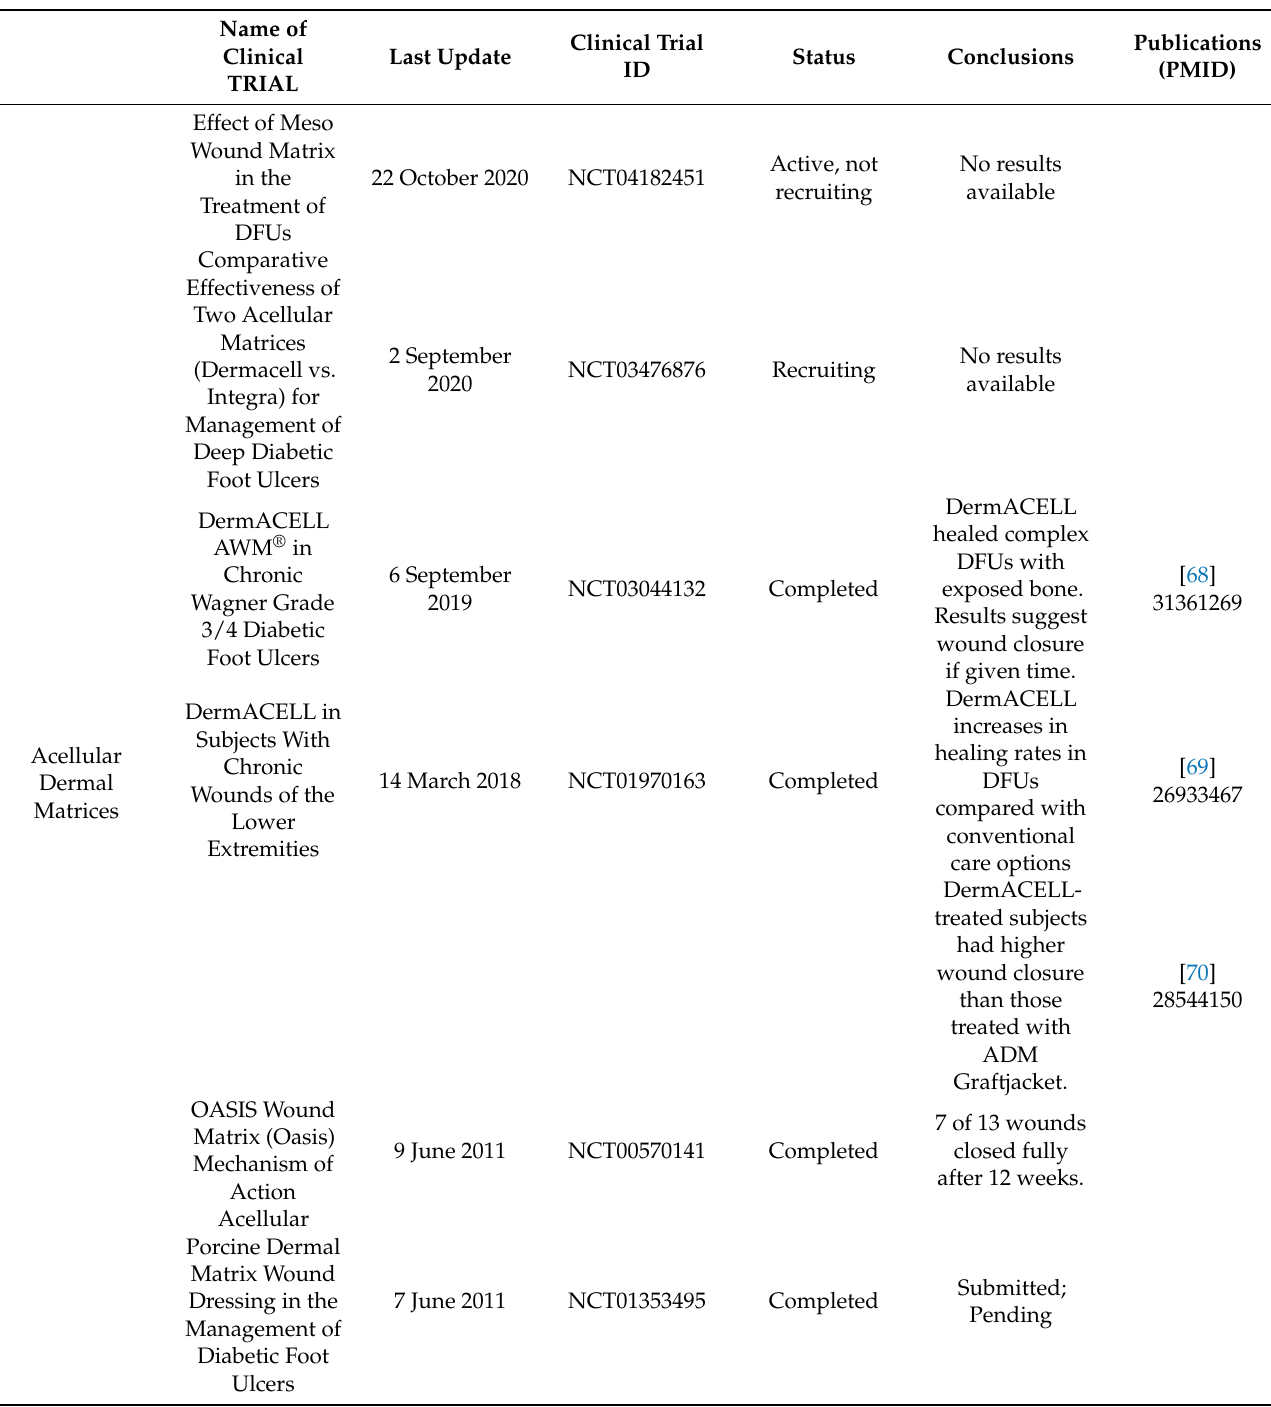
Table 1. Clinical trials involving biological materials including or with potential secondary application with skin substitutes and acellular dermal matrices in diabetic foot ulcers and impaired